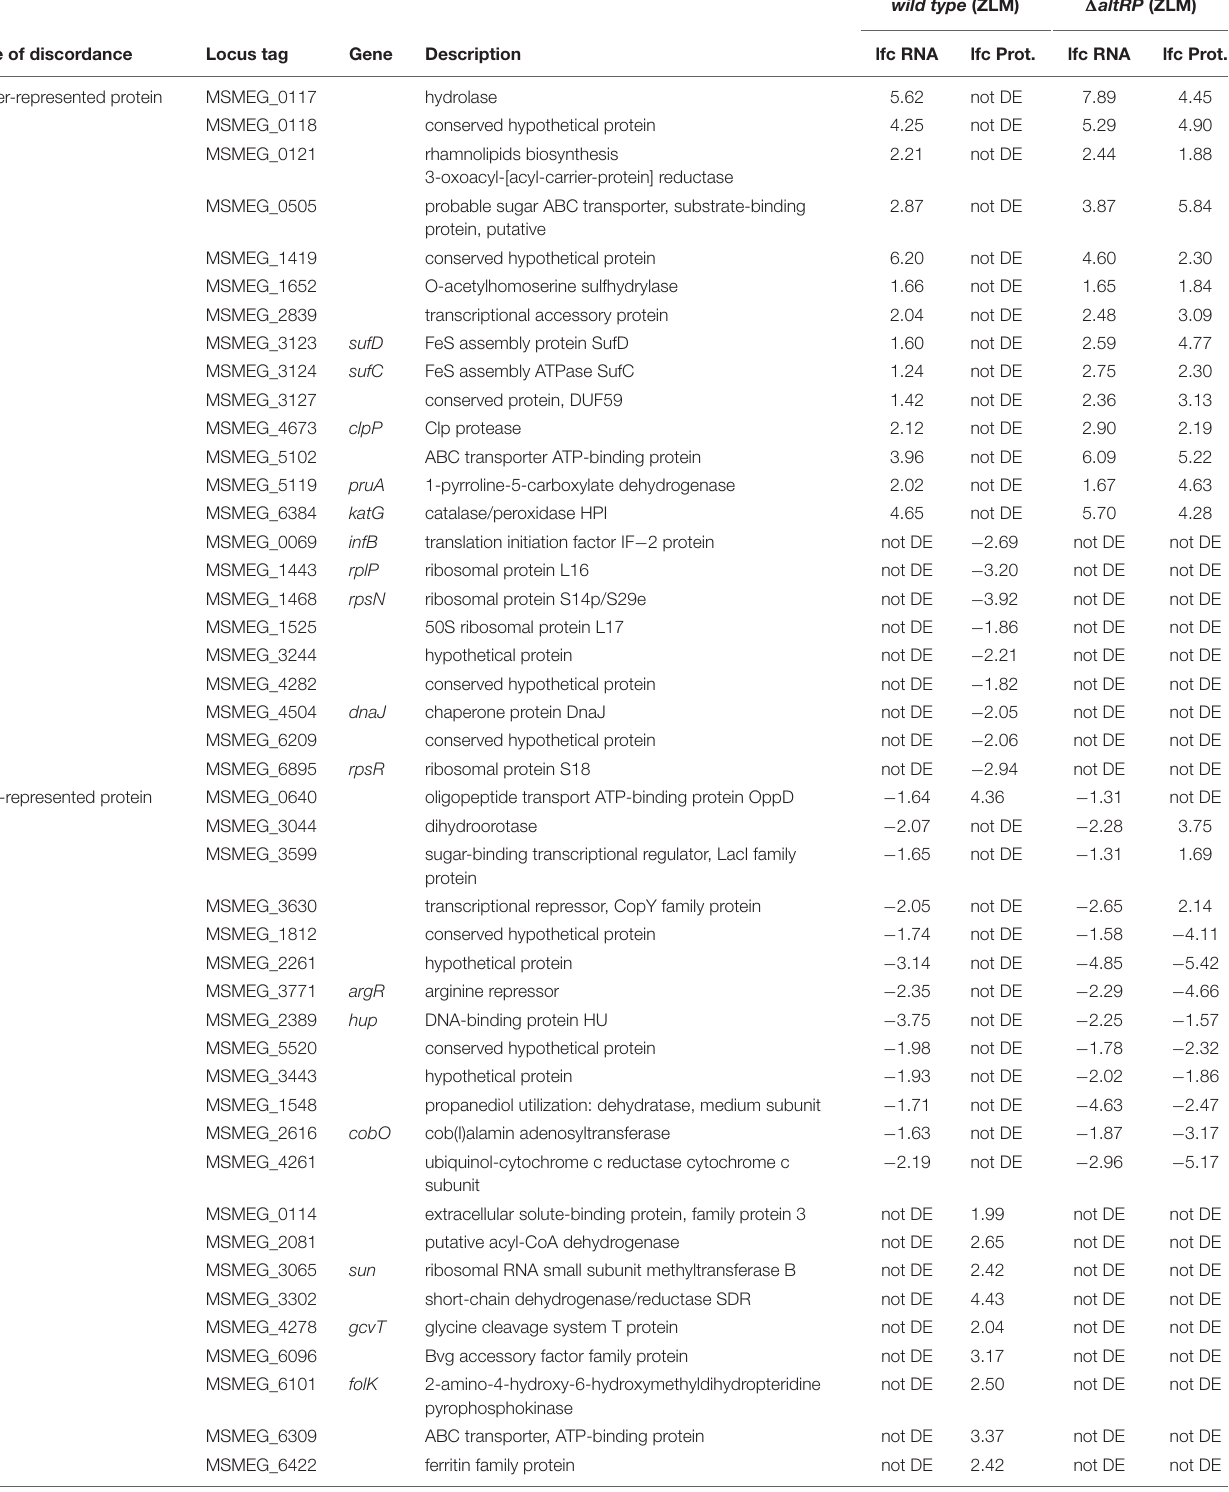
wild type (ZLM) (cid:49) altRP (ZLM)